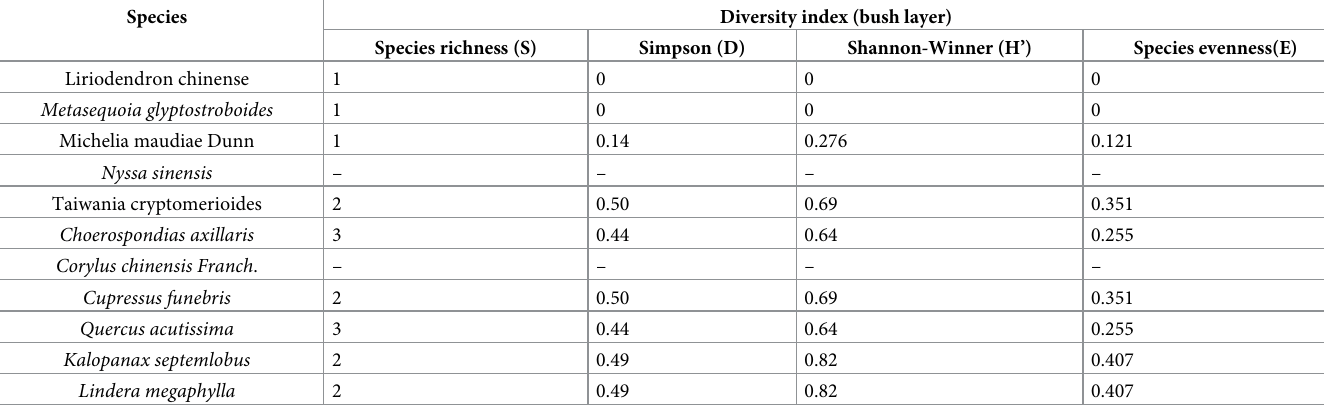
Table 4. Plant diversity indexes of bush layer of different vegetation types. Species